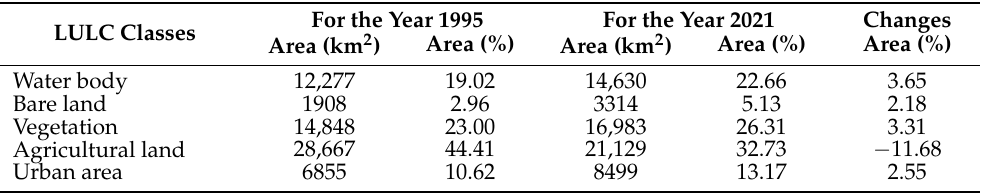
Figure 11. LULC of five classes by area and changes from 1995 to 2021. Table 2. LULC area of 1995 and 2021 for the study